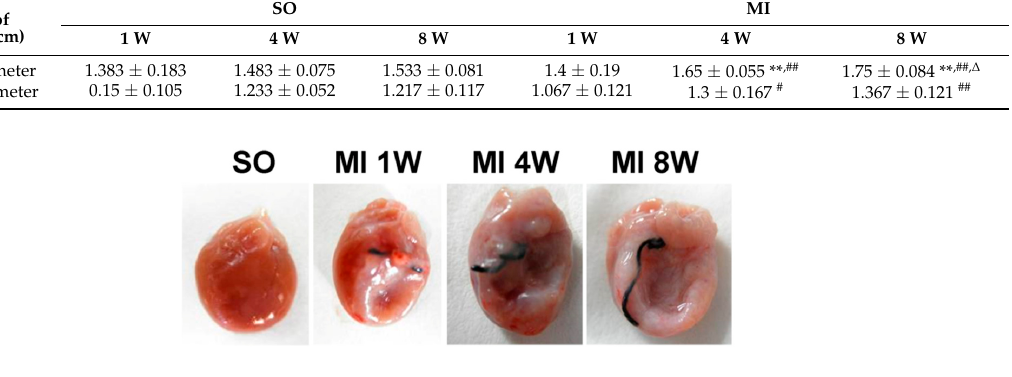
Figure 1. General observations.